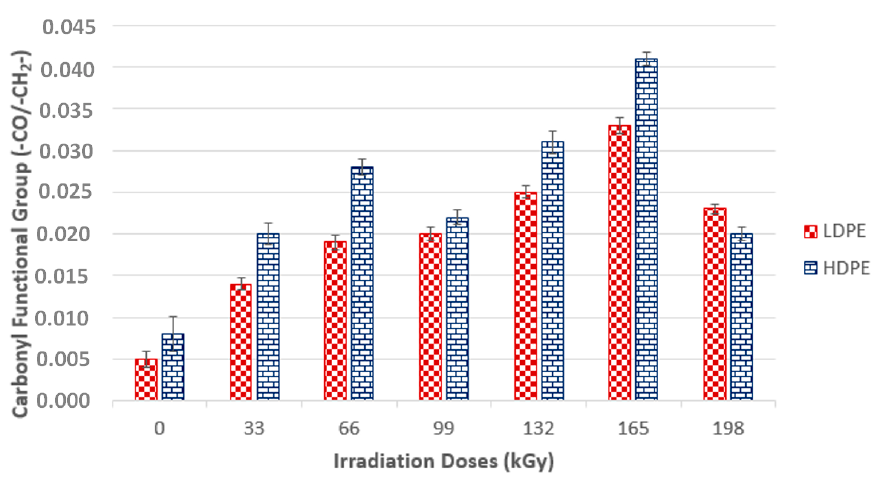
Figure 14. Relative number of hydroxyl functional groups and radiation dose relationships; the vertical line drawn at the top of the column represents the standard deviation.